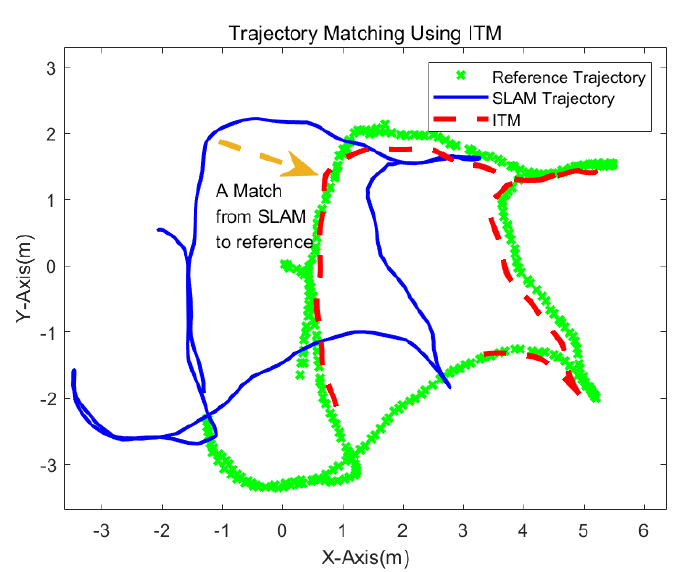
Figure 2. An Example of Trajectory Alignment in